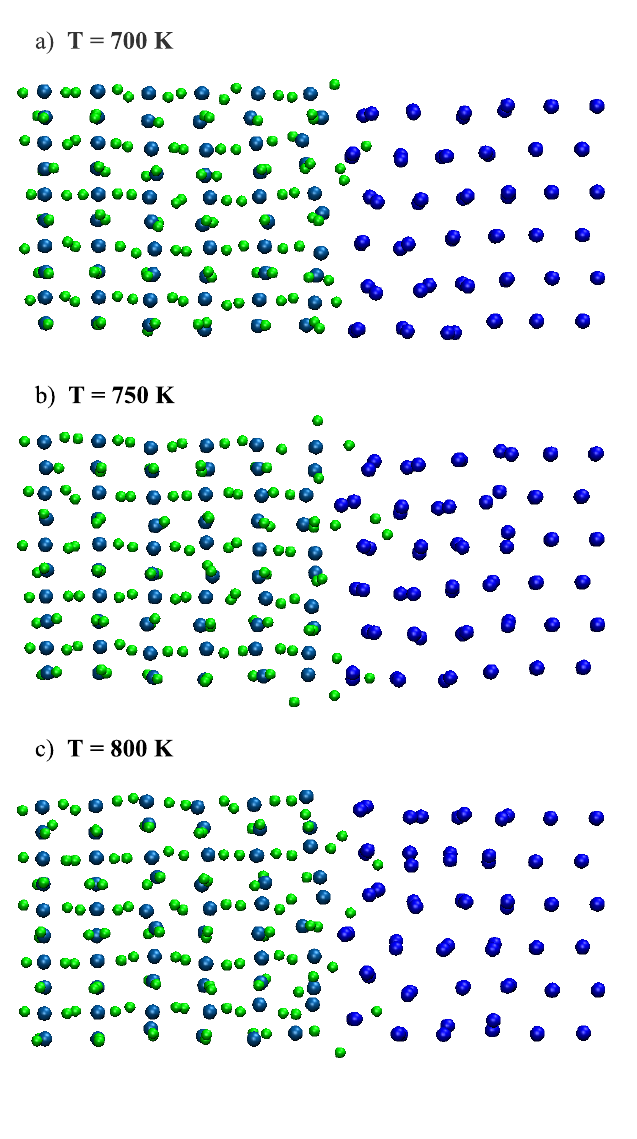
Figure 6. Snapshots of Mg-MgH interface during molecular dynamics for ( a ) T = 700 K; 2 ( b ) T = 750 K; and ( c ) T = 800 K. H atoms are in green, Mg atoms in the magnesium hydride side are in light blue and Mg atoms in the magnesium side are in dark